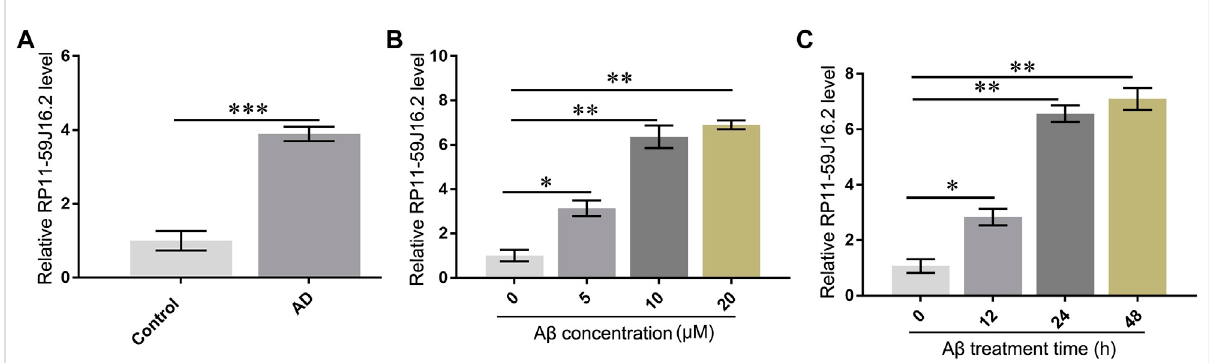
FIGURE 3 RP11-59J16.2 was overexpressed in serum of AD patients and A β treated SH-SY5Y cell model. (A) RP11-59J16.2 was highly expressed in serum of AD patients. (B) Expression of RP11-59J16.2 was detected in SH-SY5Y after qRT-PCR treatment at different concentrations of A β 1-42 (0, 5,